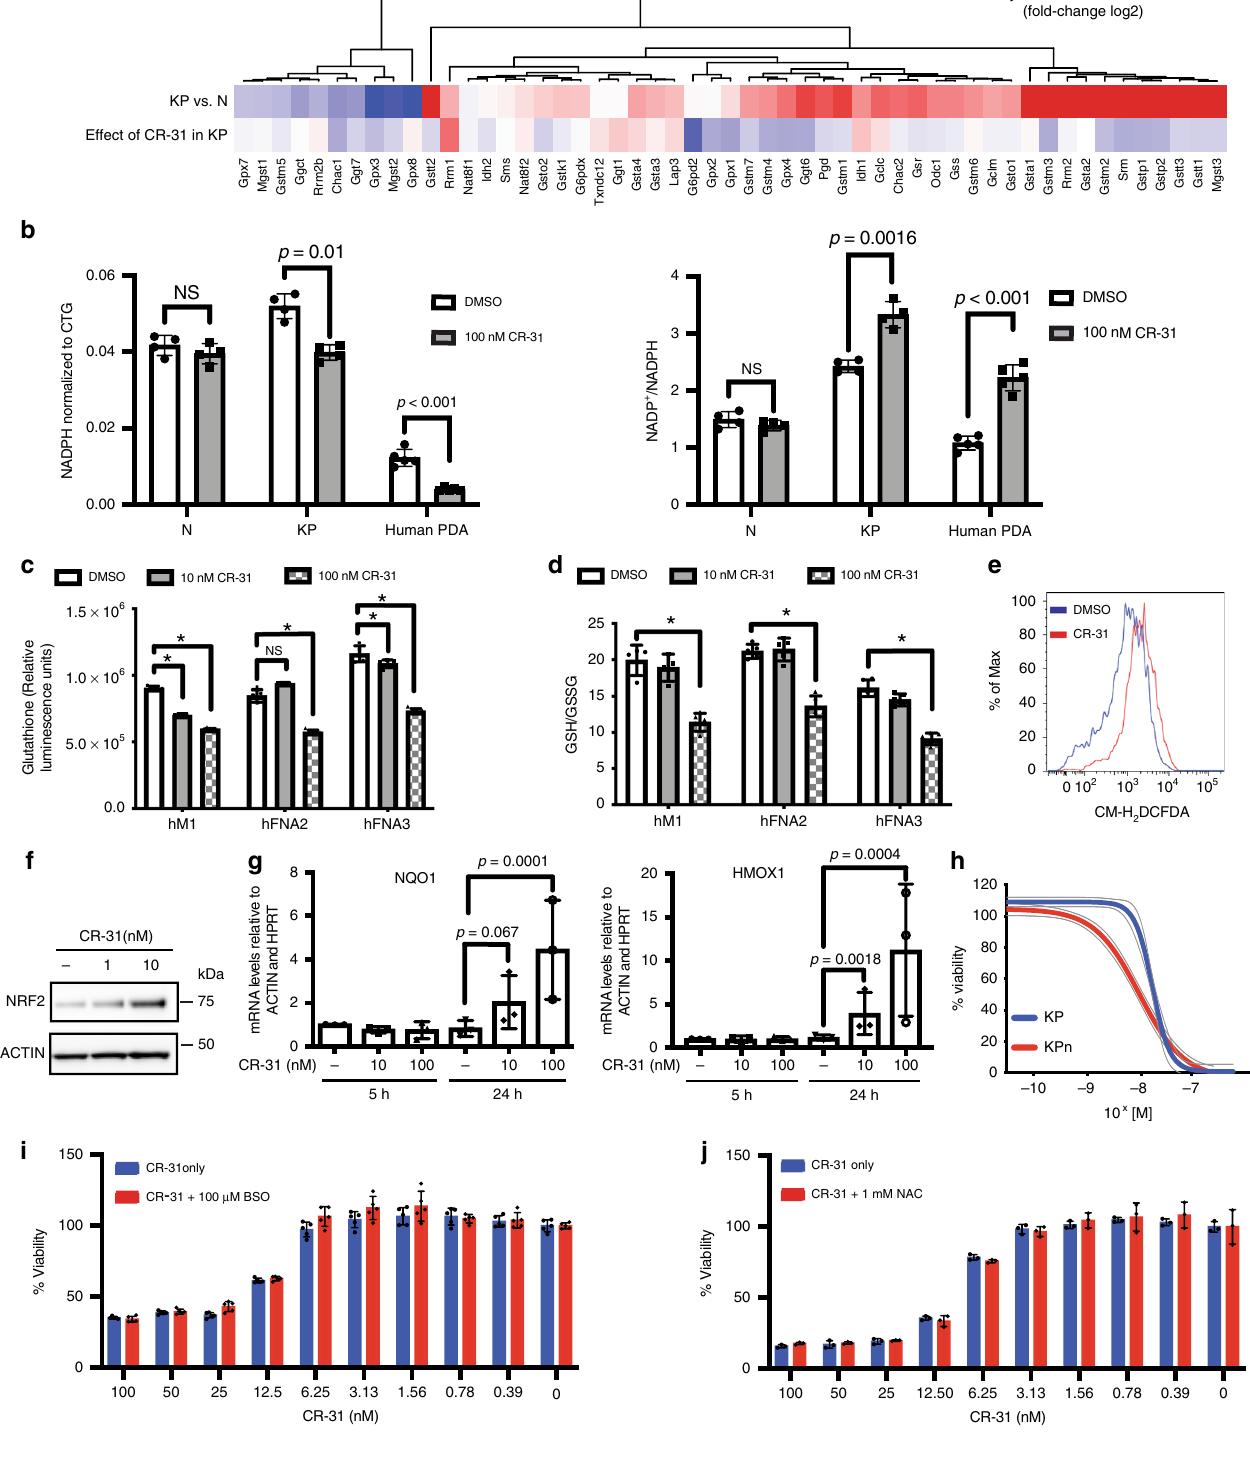
organoids (Supplementary Fig. 8d). When KP organoids (Fig. 4f, with the reduction of glycolysis in CR-31-treated PDA cells, we Supplementary Fig. 8e, f) or patient-derived PDA cells (Fig. 4f) observed a decreased contribution of 13 C 6 -glucose in all were treated with CR-31, global levels of intracellular and secreted detectable upstream intermediates of the glycolytic pathway lactate were reduced. Interestingly, this effect was much more (Supplementary Fig. 8g). In an acute glycolytic stress test, CR-31 potent in KP organoids than in N organoids (Fig. 4f). Consistent treatment for 5 h suppressed the ECAR of KP organoids (Fig. 4g) NATURE COMMUNICATIONS| (2019) 10:5151